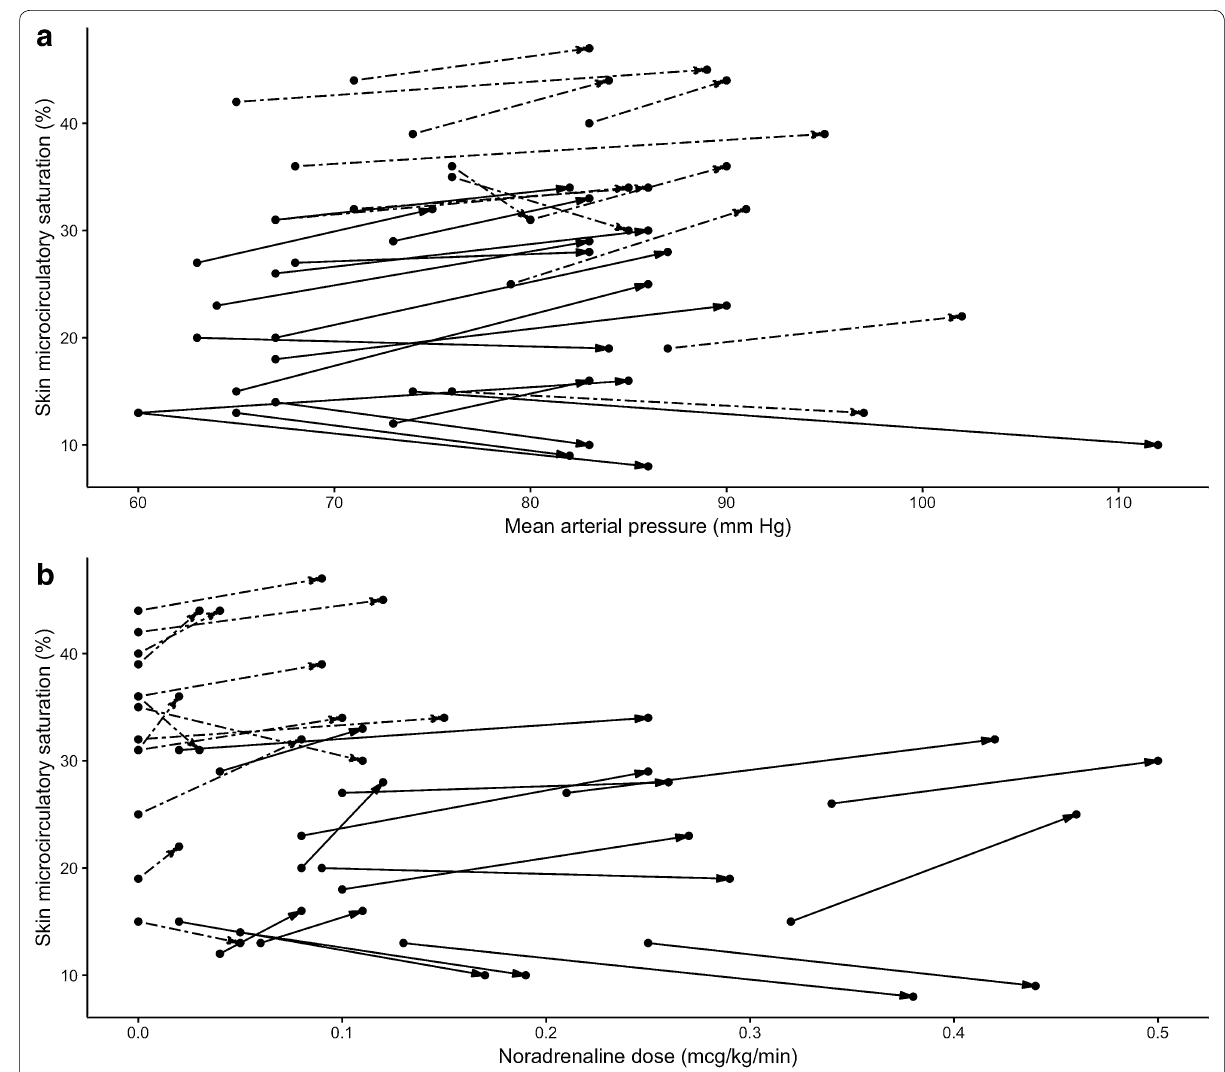
Fig. 3 Individual responses of skin oxygen saturation in sepsis (solid lines) and septic shock patients (dashed lines) to changes in a mean arterial pressure, and b dose of